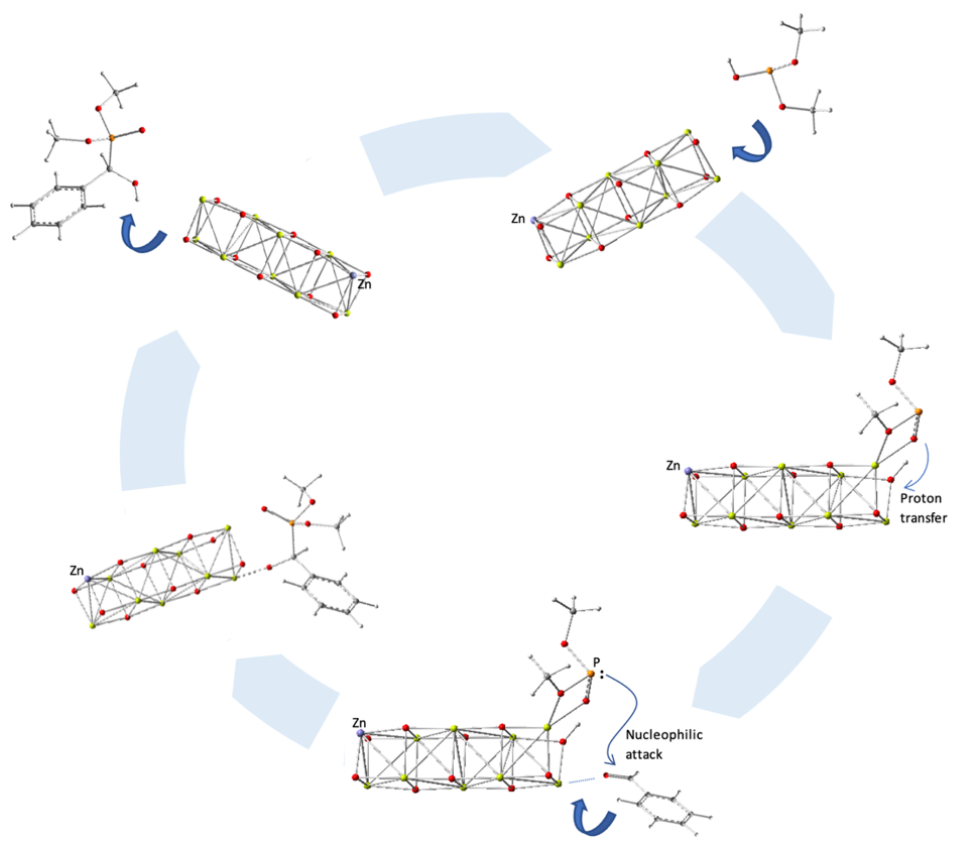
Figure 3. Catalytic cycle of the optimized geometry of a 5 × 2 × 2-MgO cluster in presence of phosphite. (Mg 0 . 9 Zn 0 . 1 )O –phosphite complex reacting with benzaldehyde and release of α -hydroxyphosphonate product before a new reaction can take place. White, gray, red, orange, yellow, and purple spheres represent, respectively, hydrogen, carbon, oxygen, phosphorus, magnesium, iron and zinc atoms.